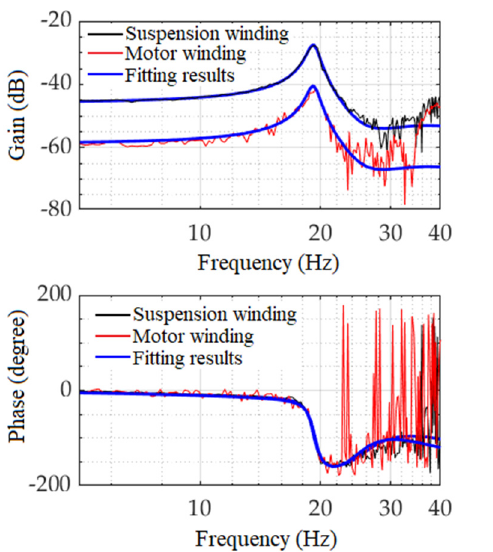
Figure 9. Measured and fitted responses of the BELM rotor. ( a ) Measured and fitted response of the BELM rotor in the X -direction; ( b ) Measured and fitted response of the BELM rotor in the Y -direction.